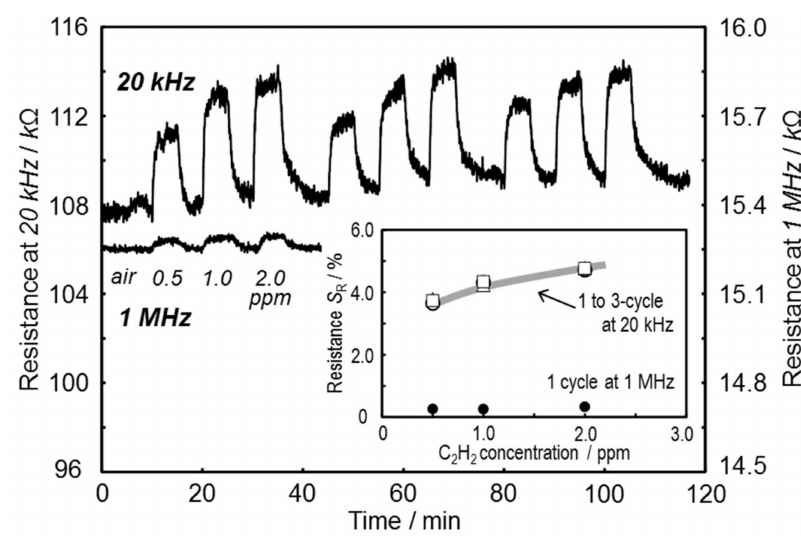
Figure 11. Response transient and concentration dependencies (insert) of the SmFeO 3 thin-film device